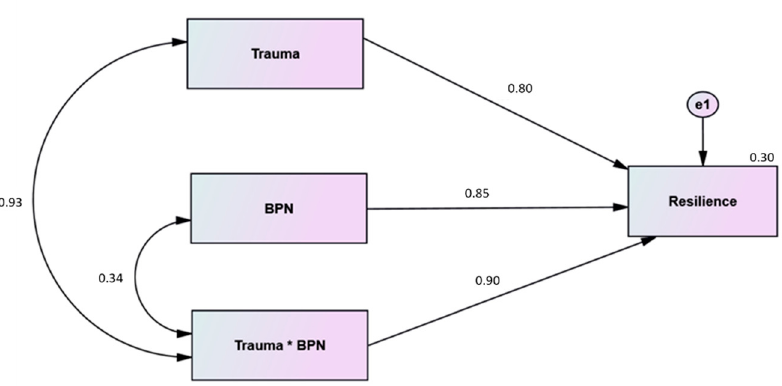
Figure 4. Modified Structural Model for Gaza Strip (effect of interaction of trauma and BPNS on resilience).